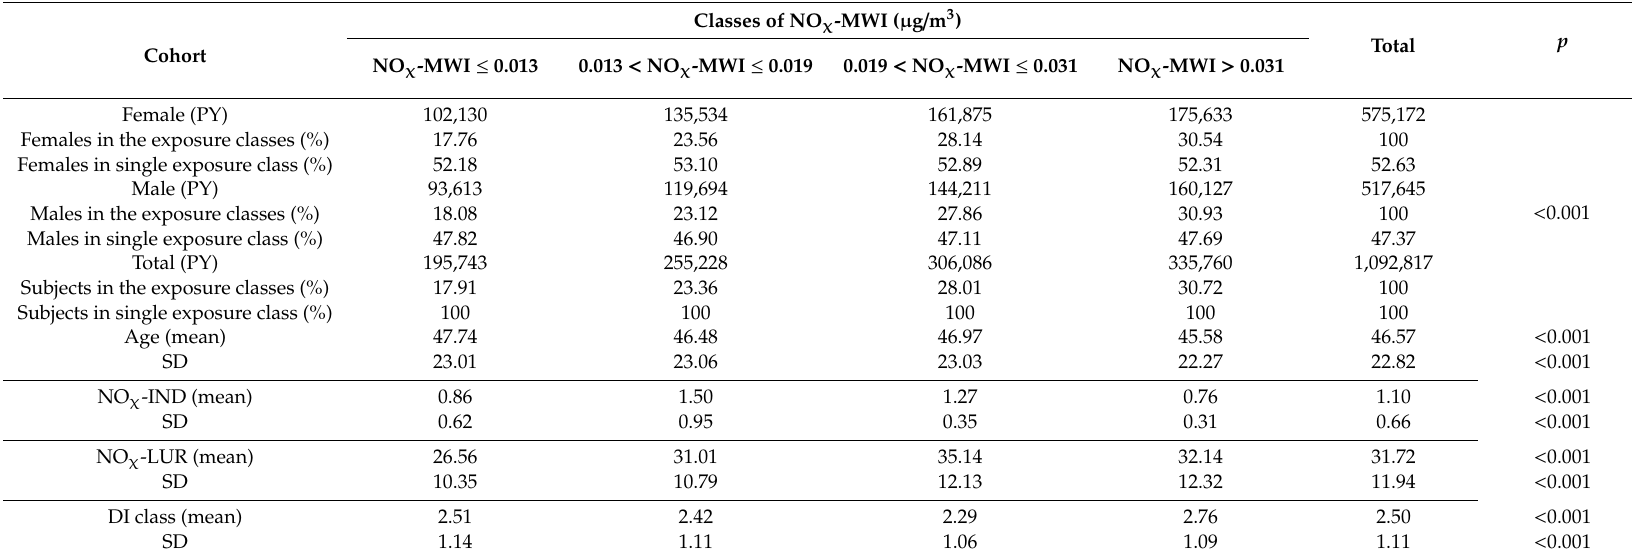
Table 1. Characteristics of the cohort by NO χ -MWI